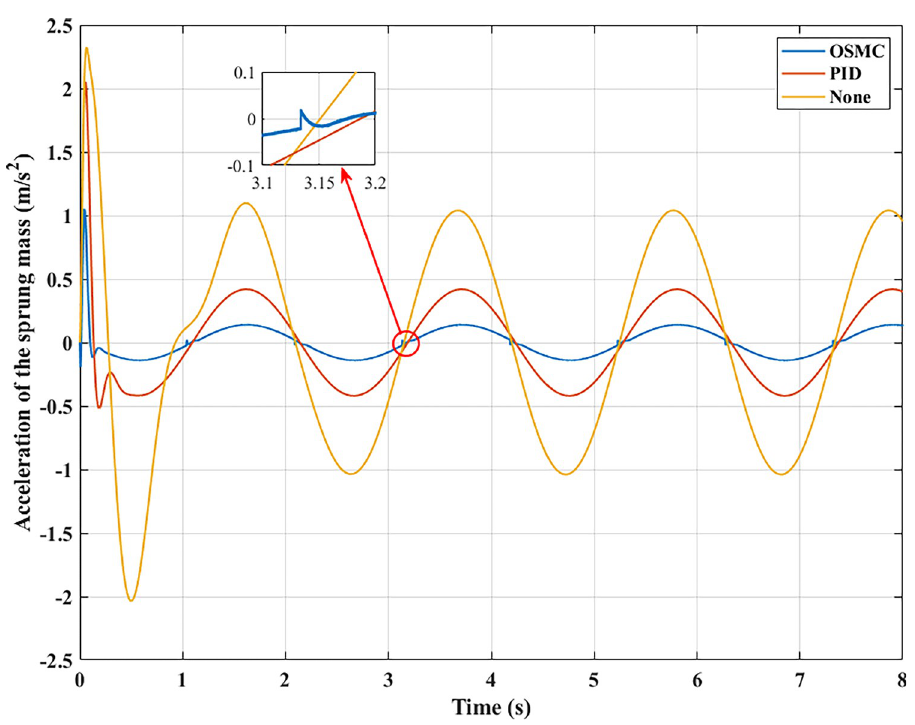
Fig 10. Acceleration of the sprung mass (case 2).